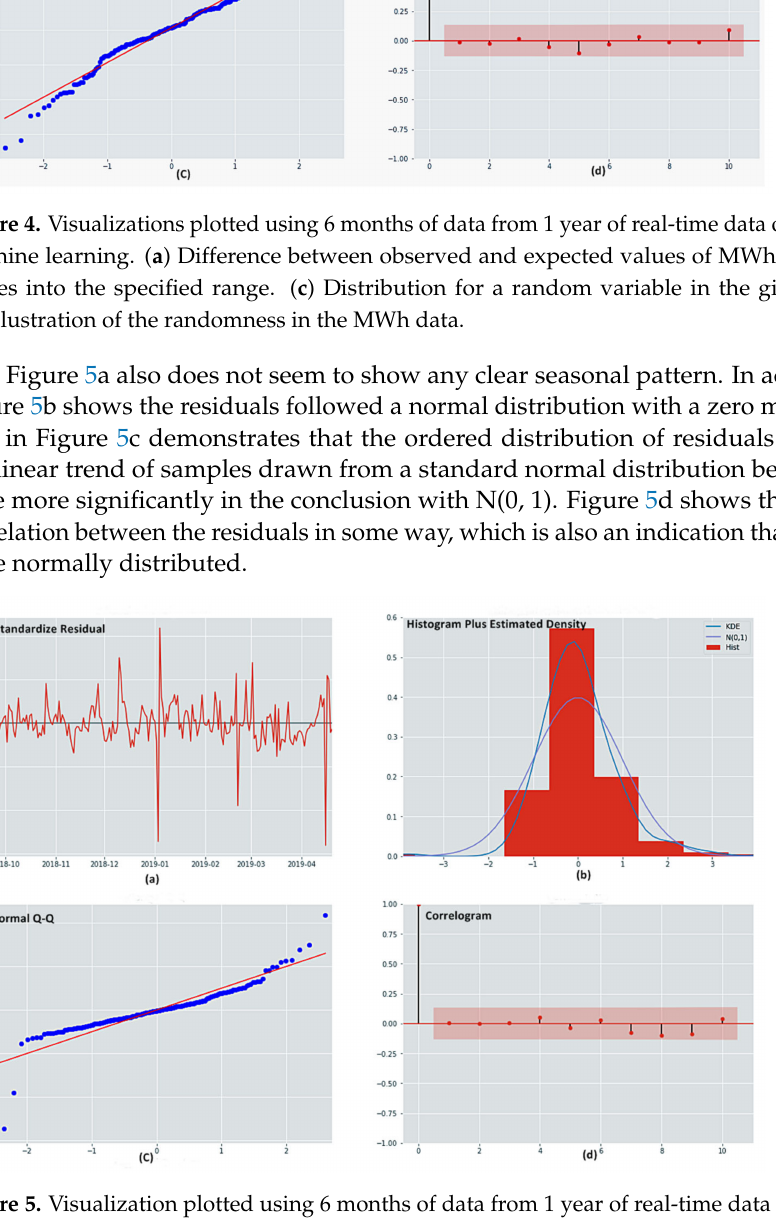
Figure 5. Visualization plotted using 6 months of data from 1 year of real-time data of POA through machine learning. ( a ) Difference between the observed and expected values of POA. ( b ) POA data values into the specified range. ( c ) Distribution for a random variable in given POA data. ( d ) Illustration of the randomness in the POA